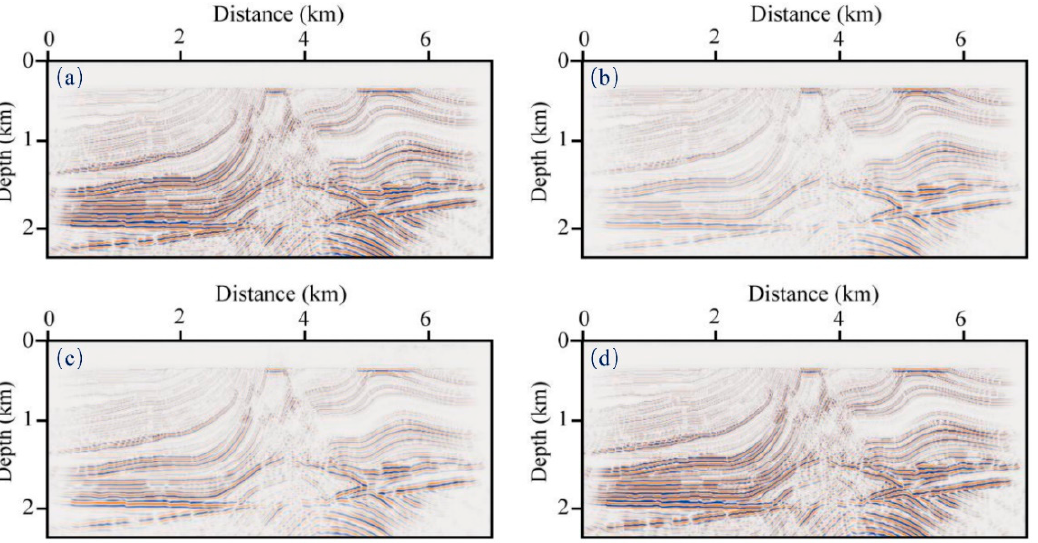
Figure 7. PP − images generated by ( a ) ERTM from lossless seismic data (reference solution), ( b ) non- compensated images, ( c ) Q -compensated with low-pass filter, ( d ) Q -compensated with the proposed a stable scheme.